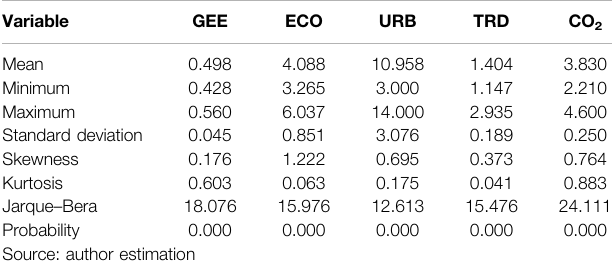
TABLE 2 | Results of descriptive